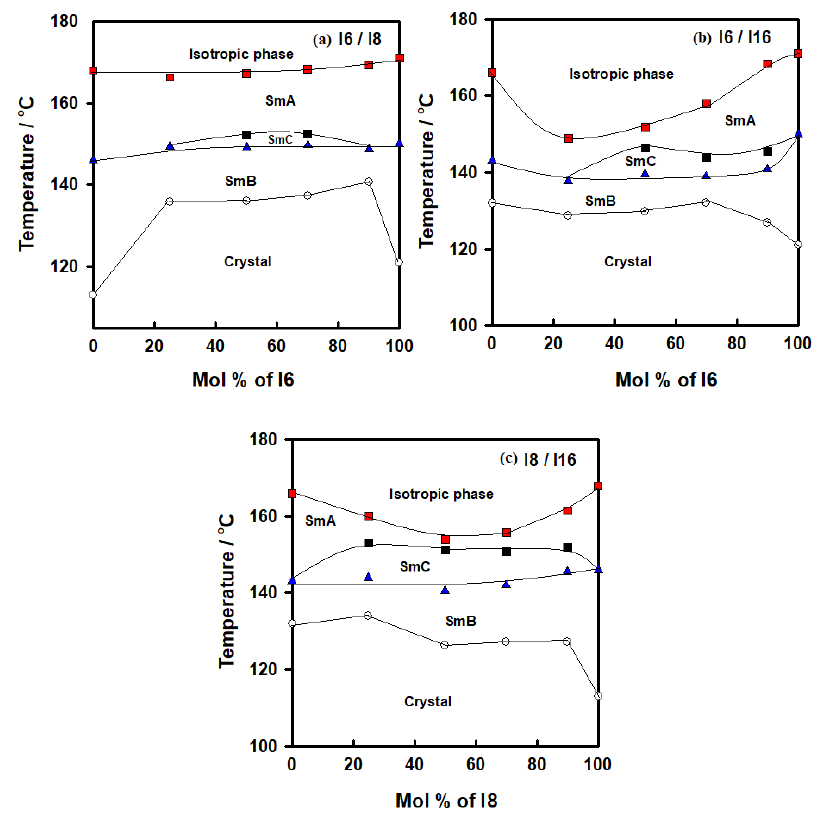
Figure 1. Binary phase diagrams for ( a ) system I6/I8 ; ( b ) system I6/I16 ; ( c ) system I8/I16